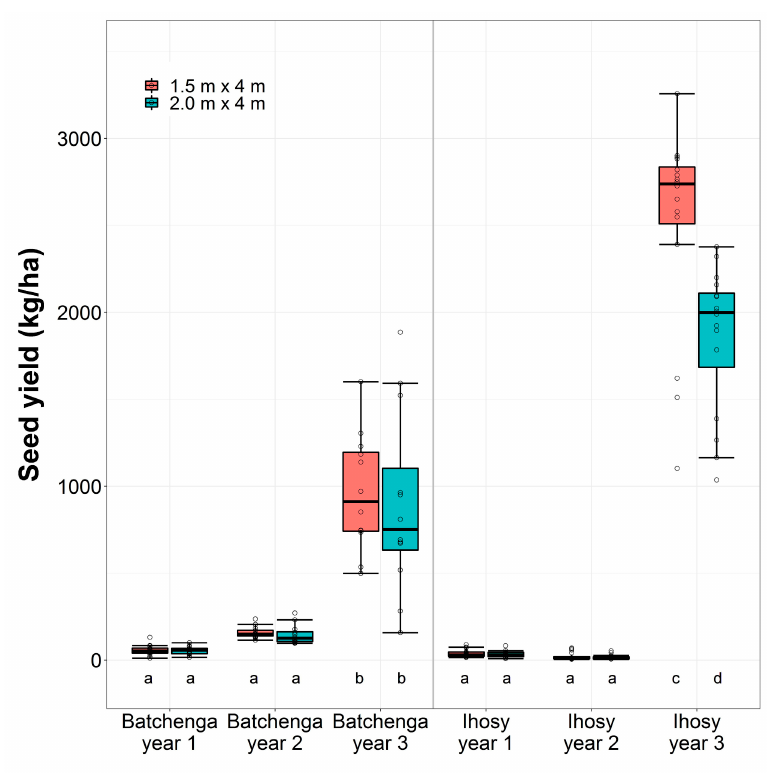
Figure 1. Boxplots of seed yields (kg/ha) per location, growing year and spacing variant. Means of treatments with the same letter are not significantly different at α = 5%.